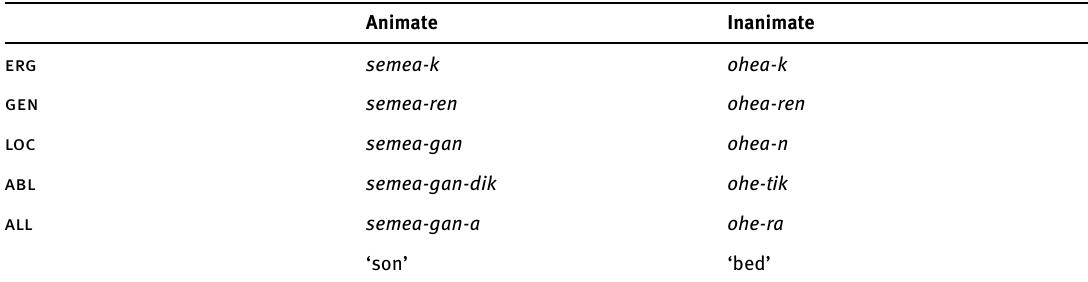
Table 1. Basque singular noun declension (partial paradigms)